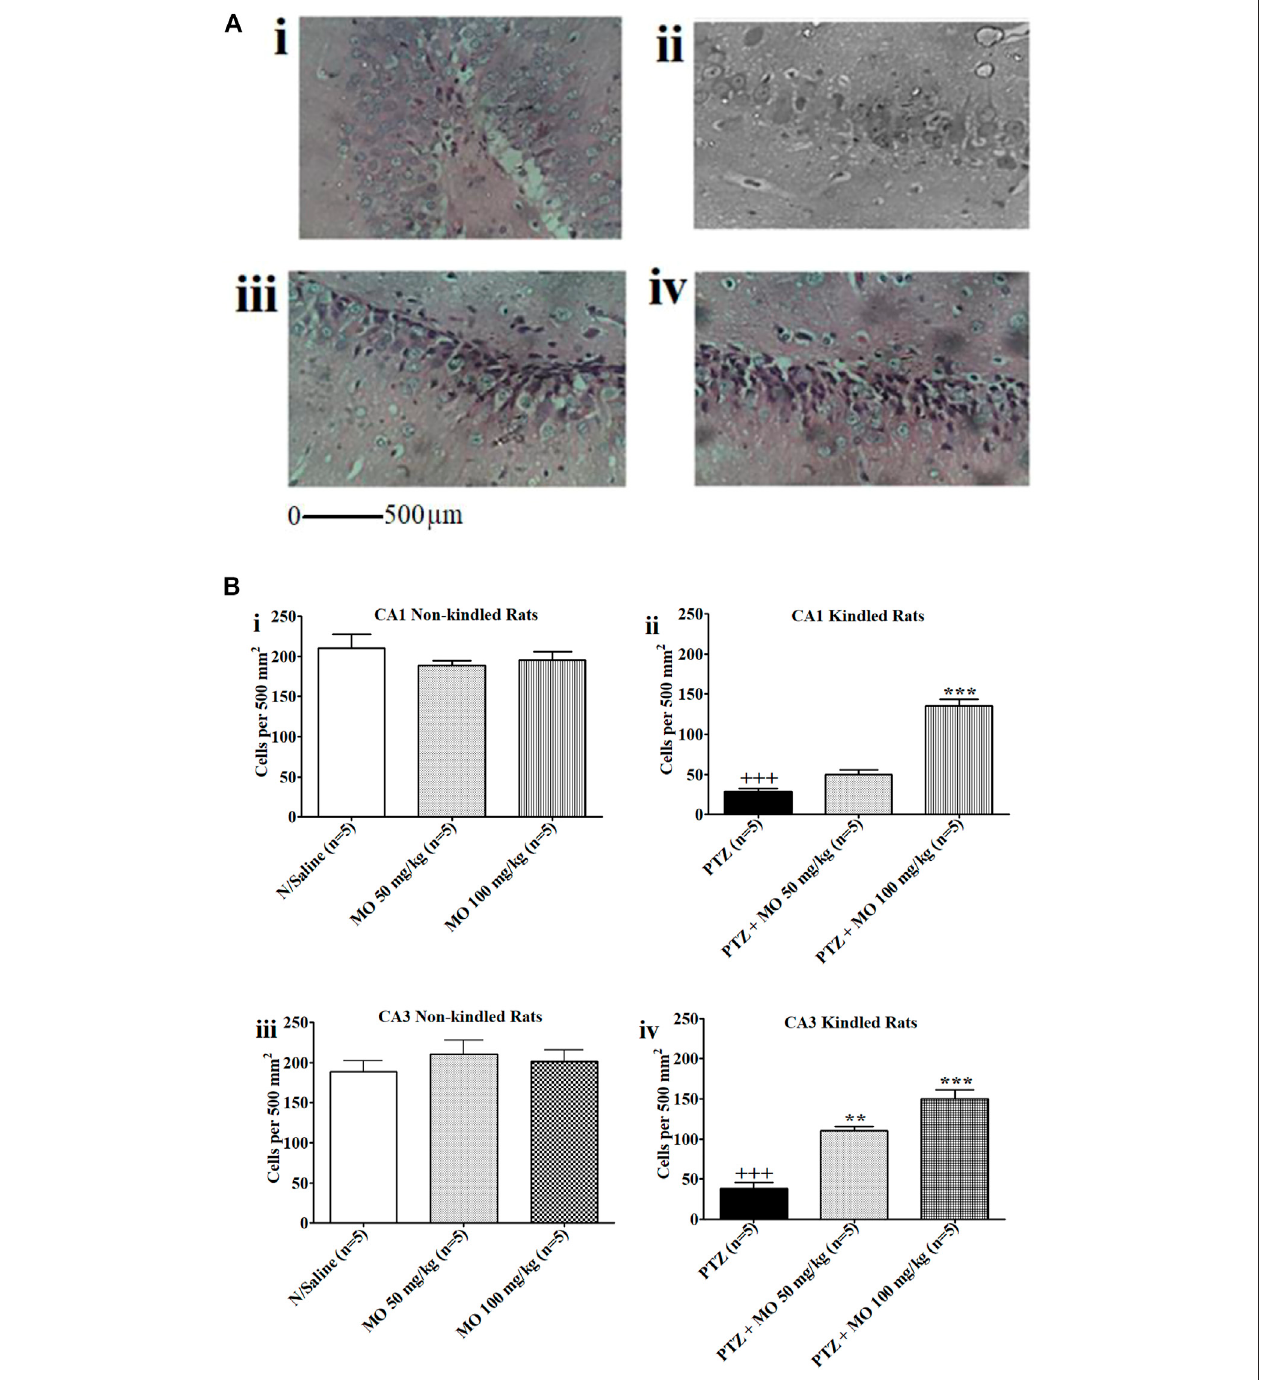
FIGURE 10 | (A) Photomicrographs i – iv. The effects of Melissa of fi cinalis L. essential oil (MO) on CA1 or CA3 neurons in the hippocampus of rats. (i) Normal Saline controlshowing highpower viewwithneuronalcell nucleiand neuralprocesses(Magni fi cation × 400); (ii)KindledratstreatedwithPTZ only(Magni fi cation × 400); (iii)Rats treatedwithPTZand 50 mg/kgofMOshowingpartialrestoration ofnucleiand neural fi brillary processes(Magni fi cation × 400);(iv)Rats treatedwithPTZ and100 mg/kg MOshowingneartotalrestorationofnucleiwiththeir fi brillaryneuralprocesses(Magni fi cation × 400); (B) Effectsof Melissaof fi cinalis L.essentialoil(MO)onnumber ofneuronsinCA1andCA3inthehippocampusofratsIncontrolanimals(sal)incomparisontopentylenetetrazole-kindledmicepretreatedwithsaline(sal)orMO.(iandii) CA1 Non-kindled and CA1 Kindled, +++ p < 0.001 (N/Saline vs PTZ), *** p < 0.001 (PTZ vs PTZ + MO 100 mg/kg); (iii and iv) CA3 Non-kindled and CA1 Kindled, +++ p < 0.001 (N/Saline vs PTZ), ** p < 0.01 (PTZ vs PTZ + MO 50 mg/kg), *** p < 0.001 (PTZ vs PTZ + MO 100 mg/kg). n (cid:2) number of animals tested. Mean ± SEM.